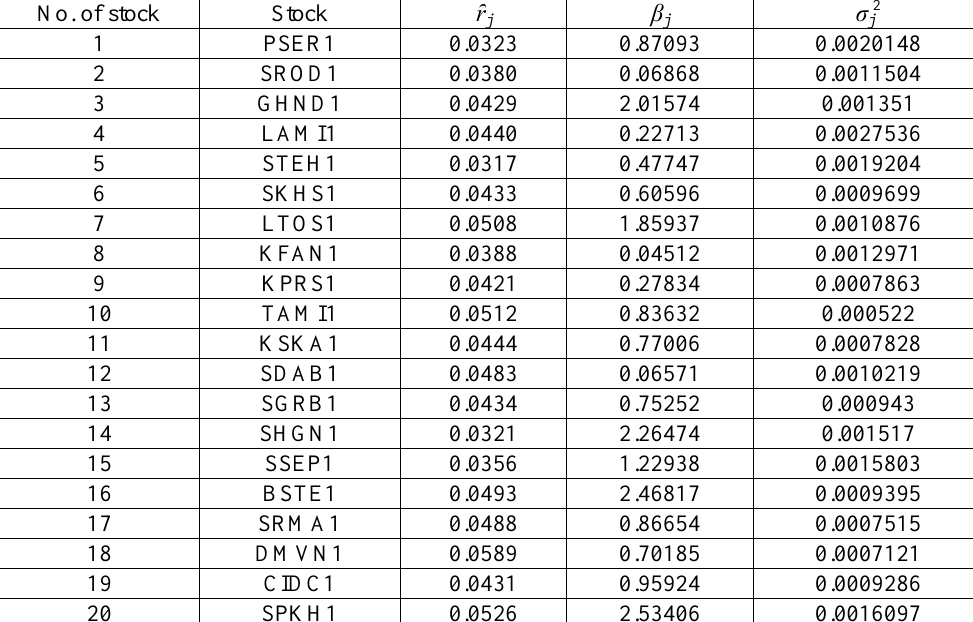
Table 6. The values average return, risk, and